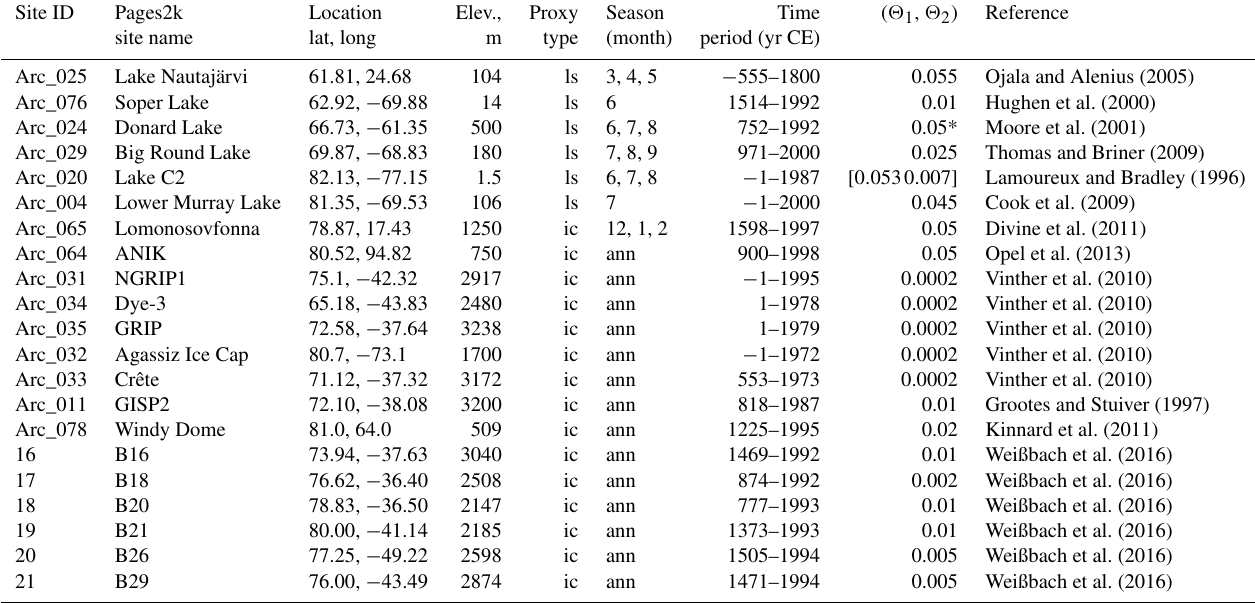
Table D1. List of the proxy records including the proxies of the Arctic2k network (PAGES 2k Consortium, 2017) with layer-counted timescales used in the present study together with parameters of the probabilistic model used in Monte Carlo simulations of the layer-counting process. The archives lacking information on the dating uncertainty are marked “*”; a conservative estimate of (cid:2) (cid:50) 1 ,(cid:50) 2 (cid:3) [0 . 05 , 0 . 05] was used in timescale